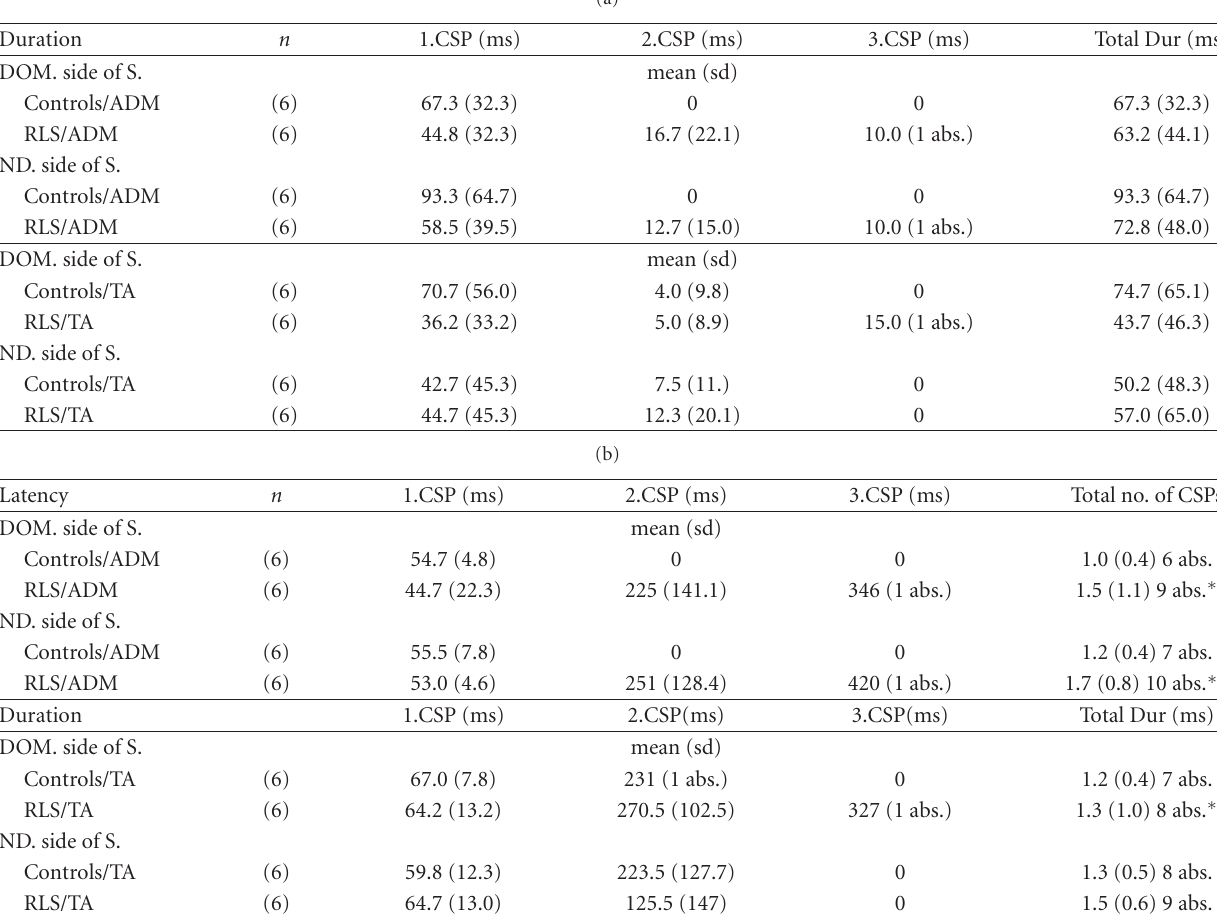
Table 3: The mean values/standard deviations of the durations (Dur) and latencies (Lat) of the first, the second, and the third CSP and the total CSP durations (Dur total), the mean and the absolute number of the CSPs in the abductor digiti Minimi (ADM) and tibialis anterior (TA) muscles in subjects with RLS and controls